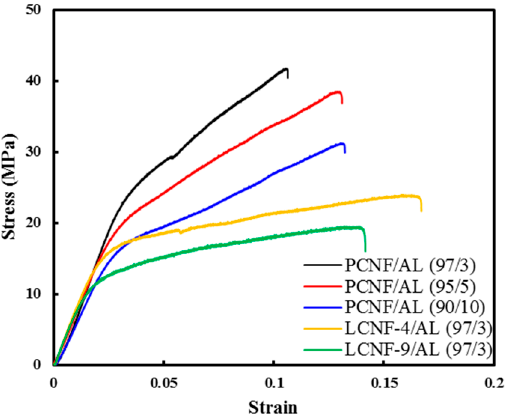
Figure 7. Stress–strain curves of wet-spun composite filament from PCNF/AL, LCNF-4/AL, and LCNF-9/AL with different AL content (spinning rate: 10mL/min).